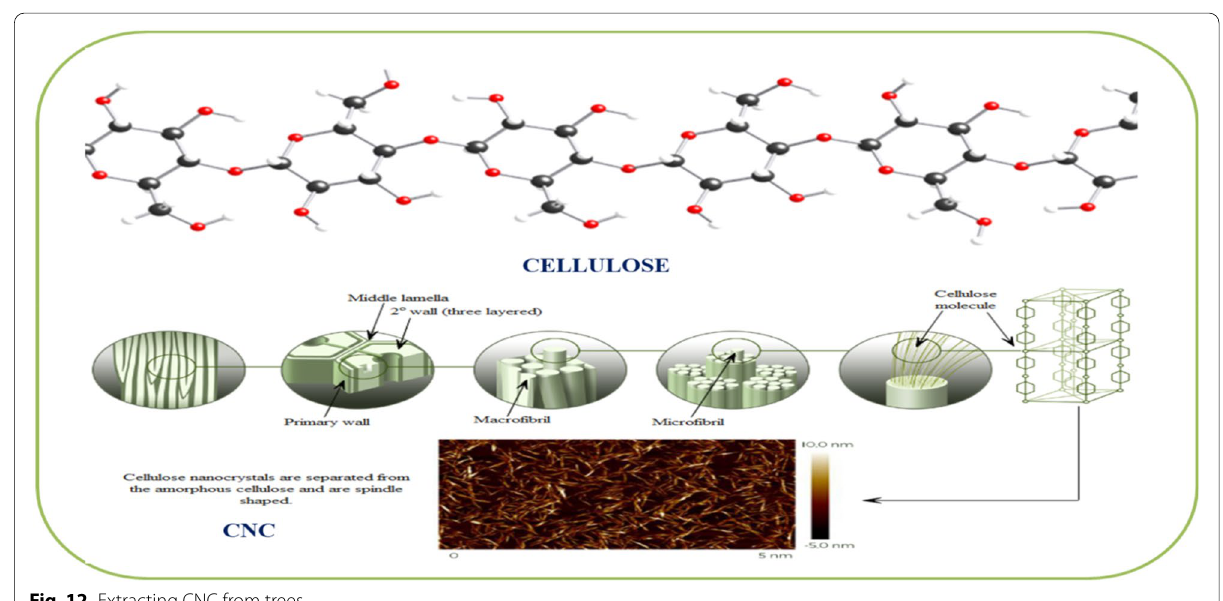
Fig. 12 Extracting CNC from